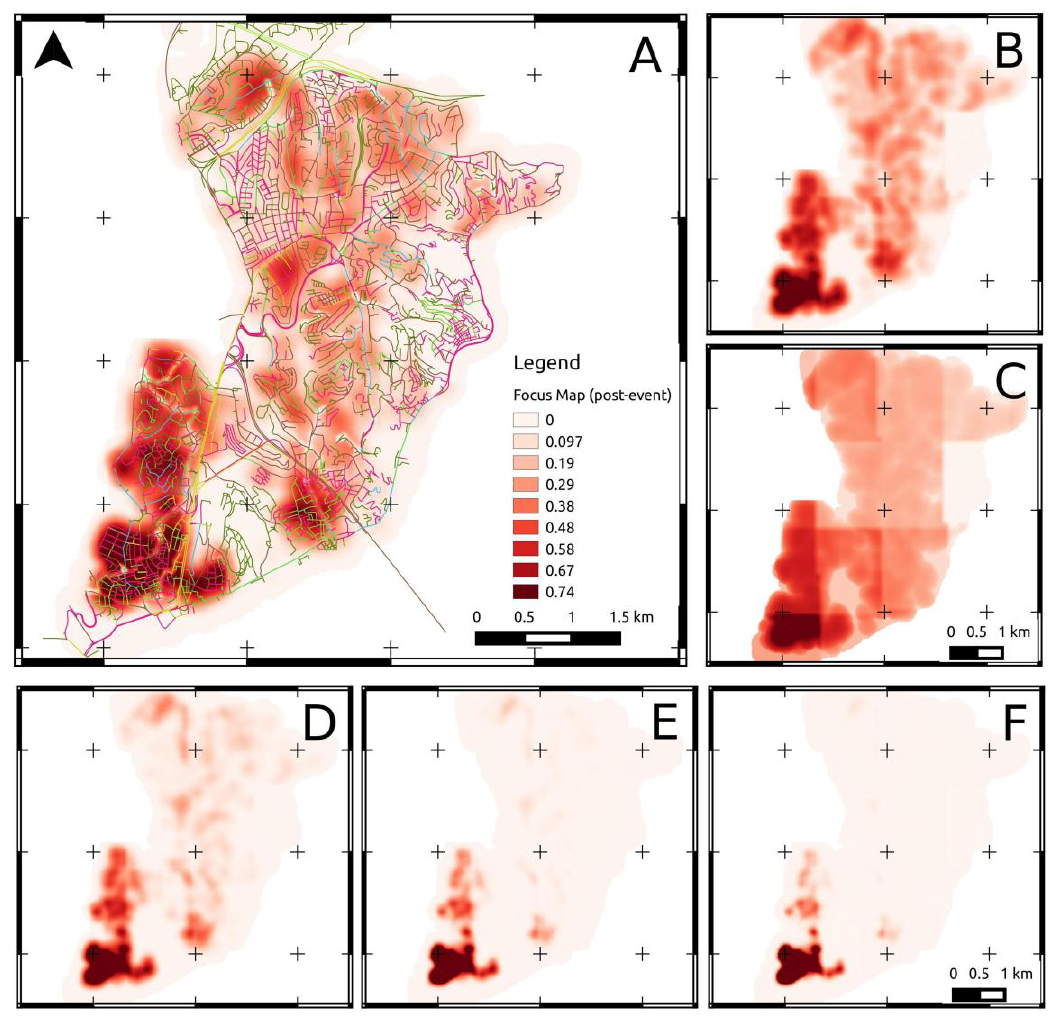
Figure 4. ( A ) Example of a focus map obtained by additive pooling of two normalized layers describing the spatial density of policies with weight w1:0.7 and the estimated seismic hazard in the district, with weight w2:0.3. ( B ) Same focus map computed with weights (0.5, 0.5). ( C ) Same focus map computed with weights (0.1, 0.9). Lower Part: post-event focus maps with increasing weights in order to increase selectivity of the sampling approach. From left to right, weights are, respectively, ( D ) (1, 1,1), ( E ) (2, 2, 2), ( F ) (3, 3, 3) where layer 1: building/policy distribution, layer 2: seismic hazard, layer 3: road